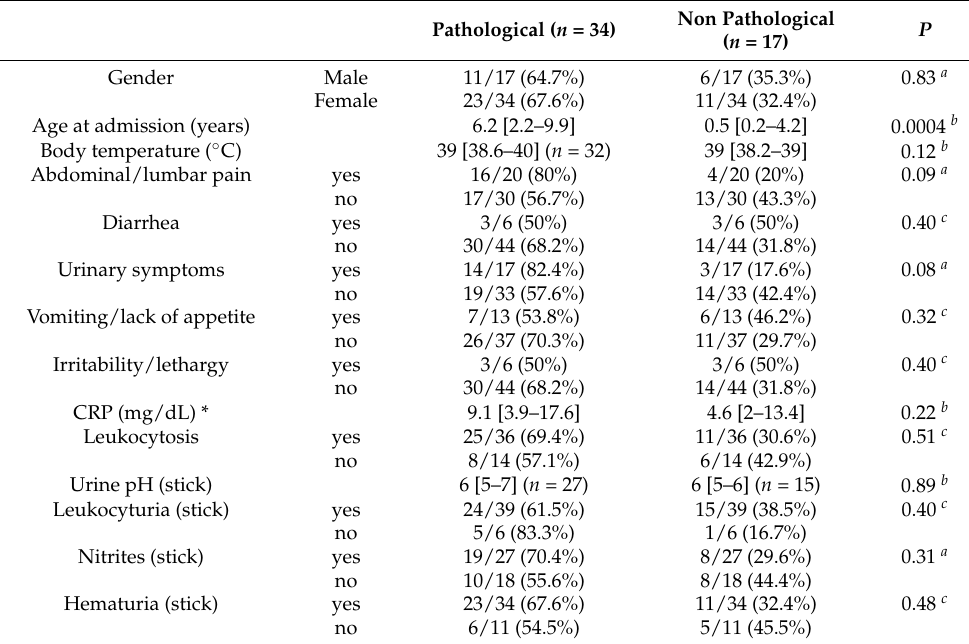
Table 3. Relationship between anamnestic and clinical data and DWI-outcome (N = 51).